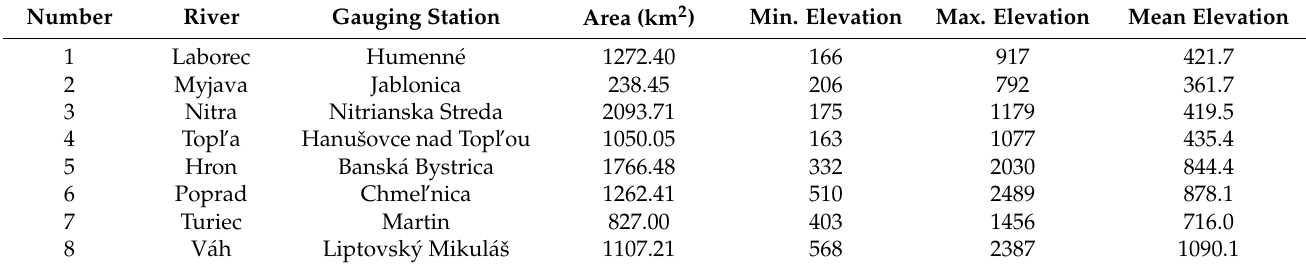
Figure 1. Topography of Slovakia and locations of the eight river basins selected. Table 1. Elevation (m a.s.l.) and size (km 2 ) of the eight Slovak